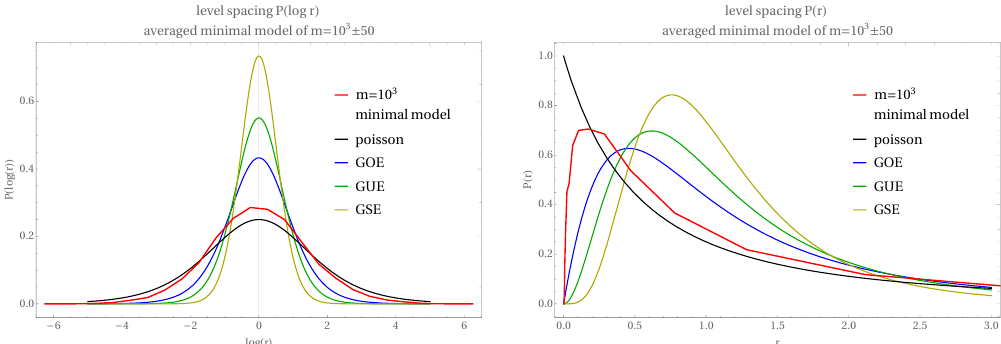
Figure 5 . The smooth curve from averaging the level statistics of the m = 10 3 (cid:6) 50 minimal models with moded energy levels, compared with the Gaussian Ensembles and the Poisson distribution. A curve with m = 3 (cid:2) 10 3 looks identical to the m = 10 3 curve. Left: distribution as a function of log of the unfolded energy level r . Right: distribution as a function of the unfolded energy level r